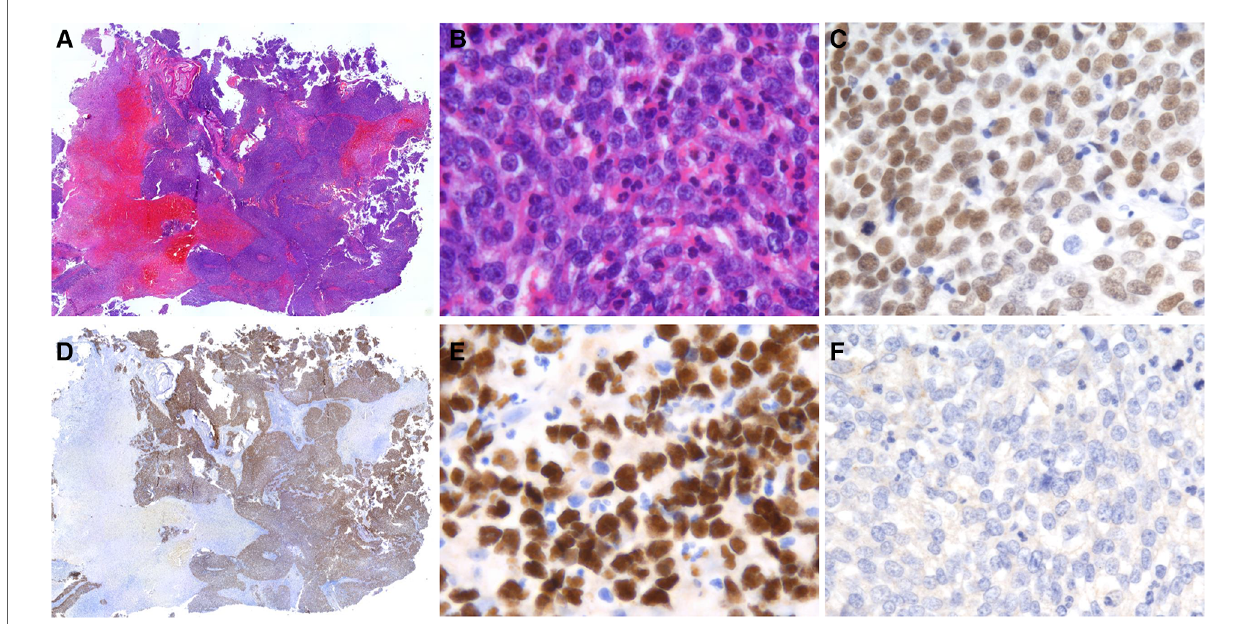
FIGURE 2 Histological and IHC fi ndings of sinonasal NUT carcinoma. ( A ) HE staining showed that NUT carcinoma grew as sheets and nested of cells (Case 1, original magni fi cation ×50). ( B ) The tumor was predominantly composed of small to middle-sized cells with scant cytoplasm. Marked in fi ltration of neutrophils was seen (Case 2, original magni fi cation ×400). ( C ) Diffuse expression of p63 was observed in all cases (Case 1, original magni fi cation ×400). ( D,E ) Positive nuclear NUT immunostaining was present (Case 1, original magni fi cation ×50, ×400). ( F ) PD-L1 was negative in all cases (Case 1, original magni fi cation ×400).